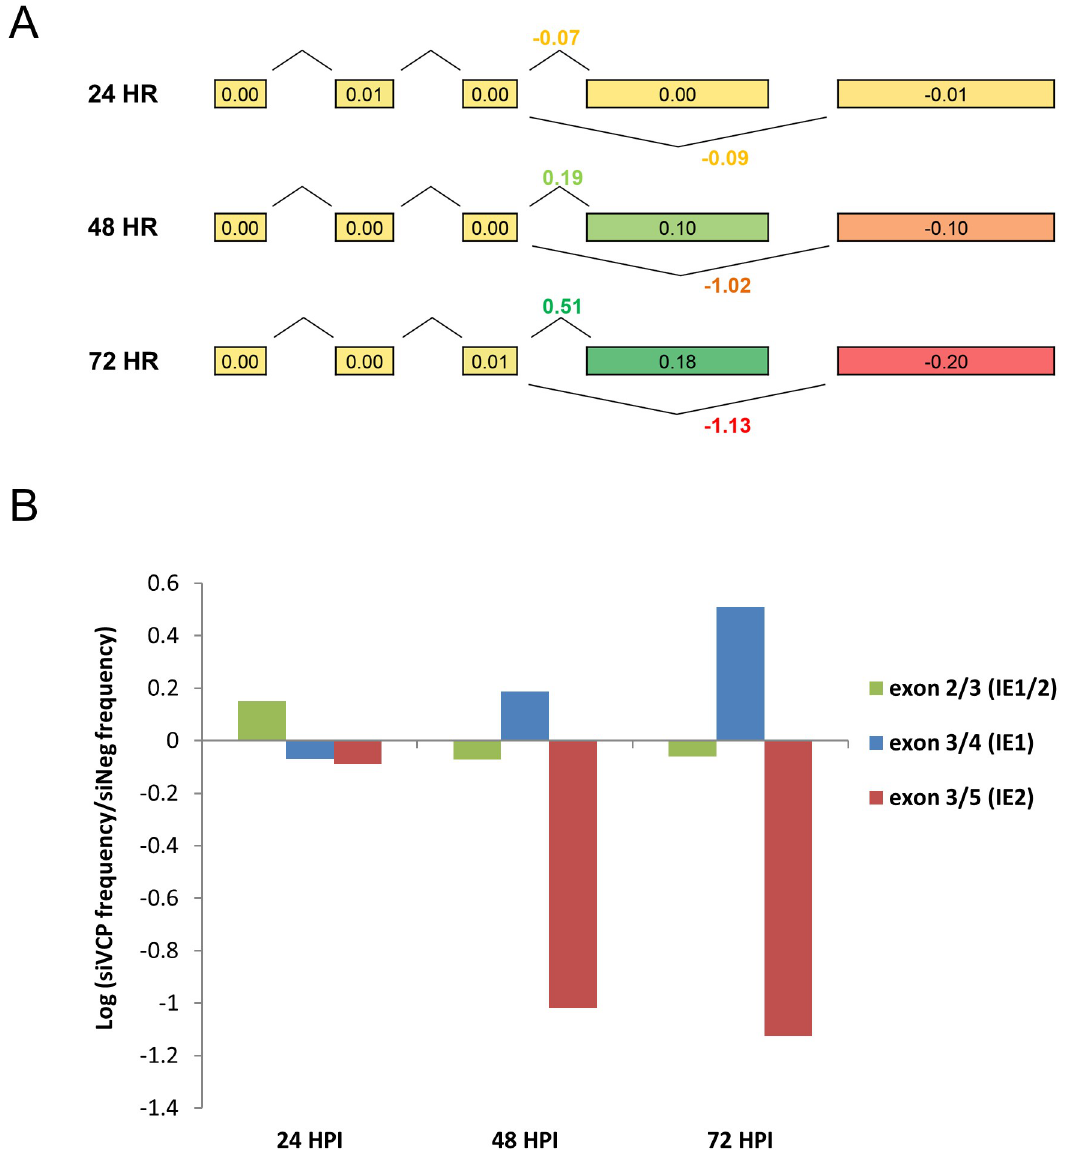
Fig 6. Knockdown of VCP alters splicing of MIE transcripts. RNA-seq analysiswas performed to measurerelative splicing levels of the MIE regionfollowingVCP knockdown. (A) The proportionof total reads mappingto each of the five exons was calculated, with the absolute difference in these values betweenVCP knockdown and corresponding negative control shown (numbers within exons). Knockdown of VCP has no effect on the proportionof reads originatingfrom exons 1, 2 or 3, but is associated with a greater proportionof reads derived from exon 4 (IE1) and decreasednumbers from exon 5 (IE2). (B) Log 2 ratios of the proportions of reads mappingto exon 3 whose matchingpair maps to either exons 2, 4 or 5 are shown. The proportionof read pairs spanning the shared splice junctionbetweenexon two and three is unaffectedby VCP knockdown, whereasexon 3 to 4 frequencyincreasesand 3 to 5